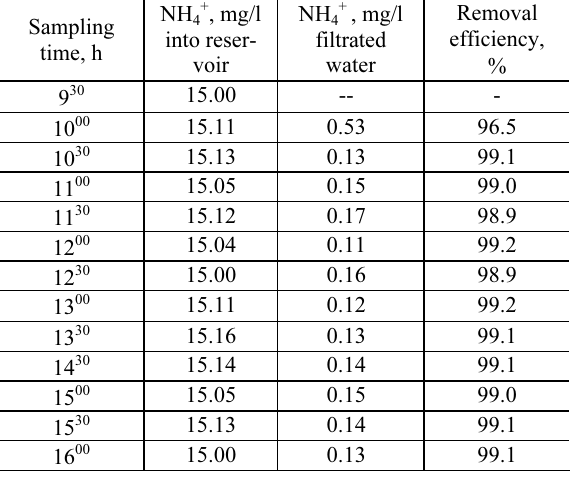
Table 4. Results of NH 4+ removal from water under dynamic